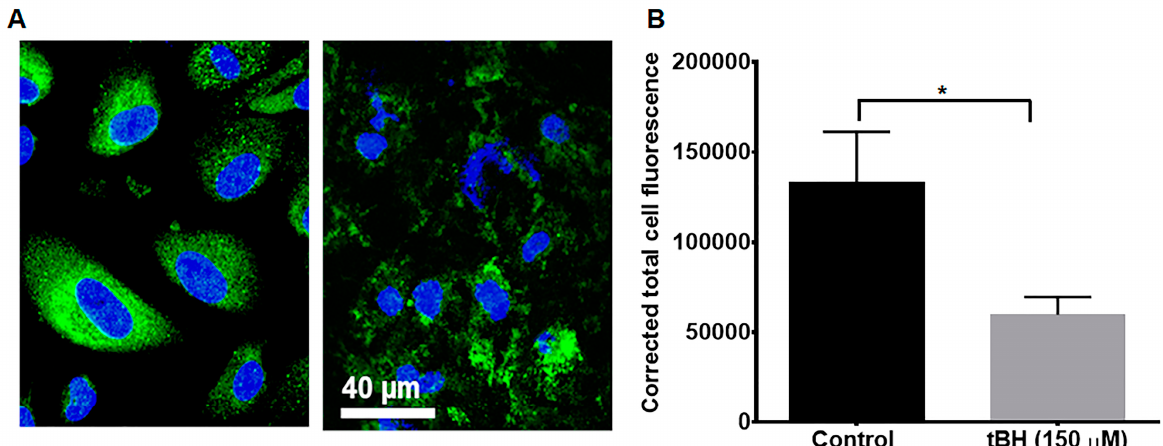
Figure 1. Effect of stress on the expression of LDLR in primary hRPE. ( A ). Primary hRPE cells were cultured in serum free medium and treated with 150 µM tBH for 24 h. Cells were fixed, blocked, and stained for LDLR (green). LDLR expression and localization are altered with stress. ( B) . Quantification revealed that in the tBH-treated cells, LDLR expression was significantly lower than the control cells. Data are shown as mean ± SEM ( n = 6, * p < 0.05).